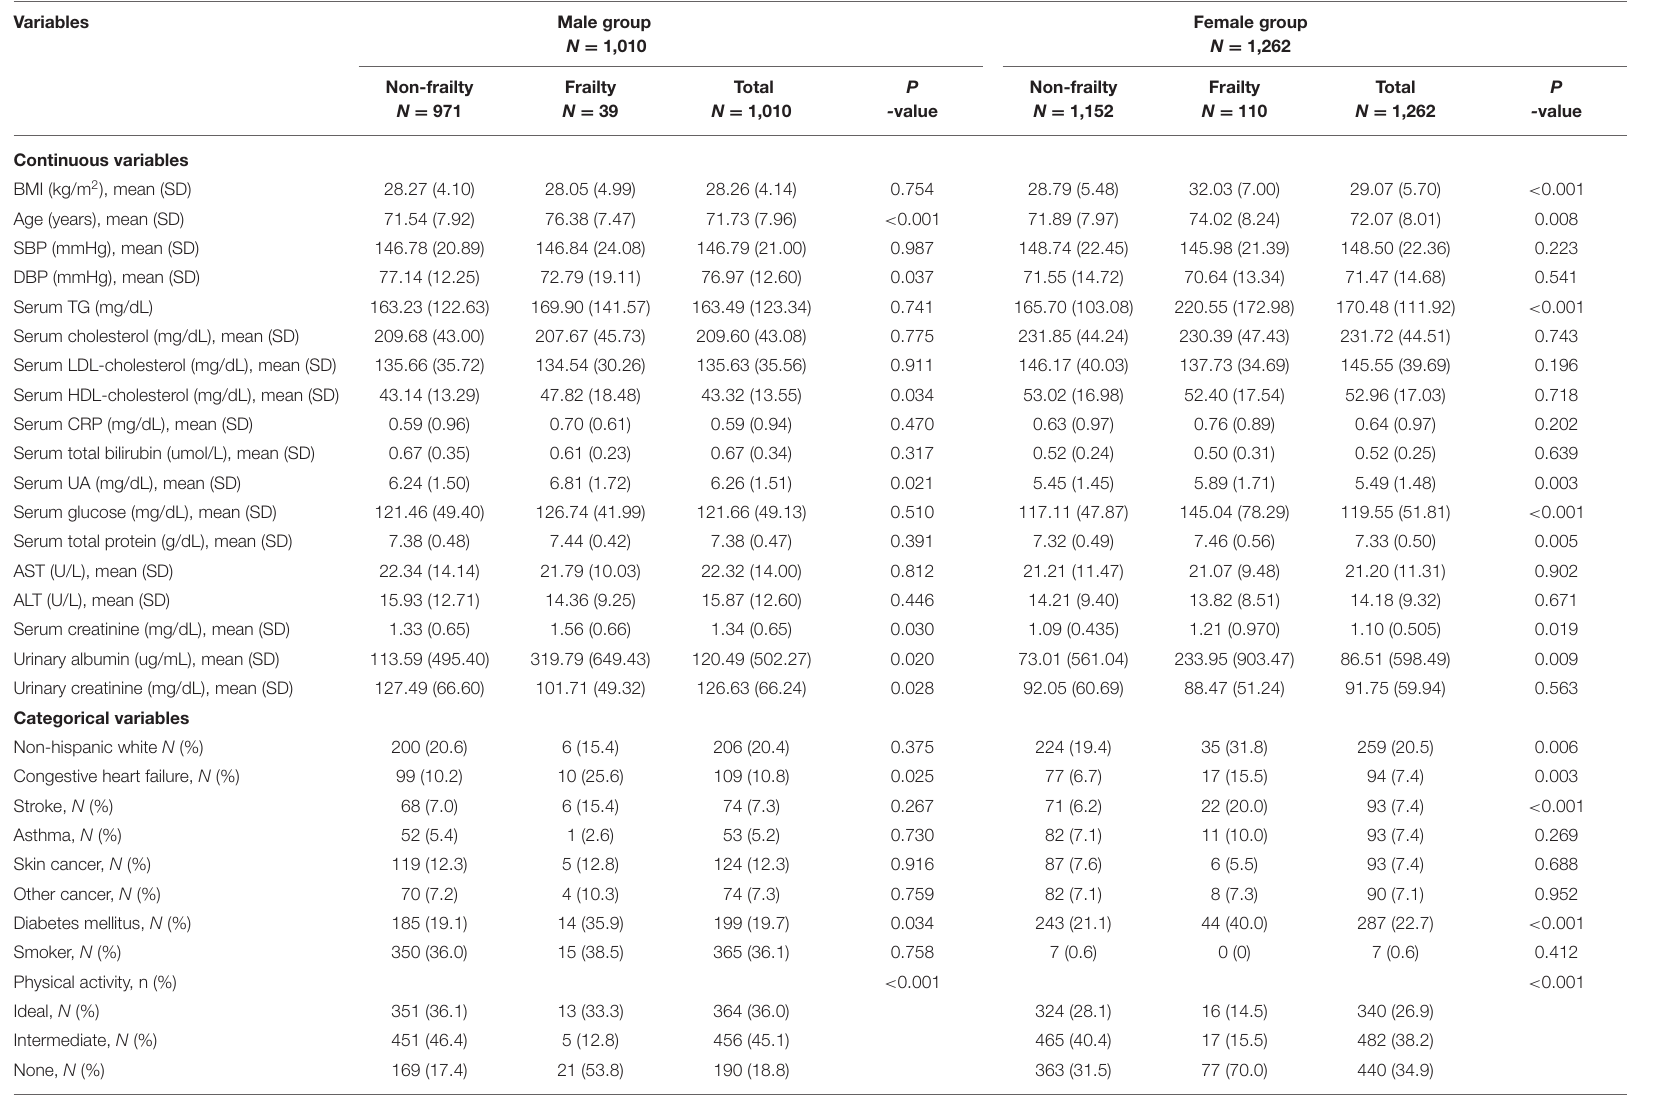
TABLE 1 | Metabolic syndrome participant characteristics by gender, frailty, and Non-frailty.